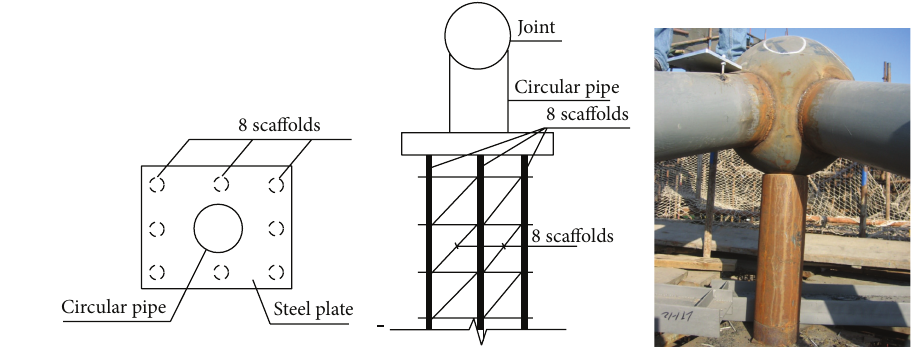
Figure 4: Temporary supports.